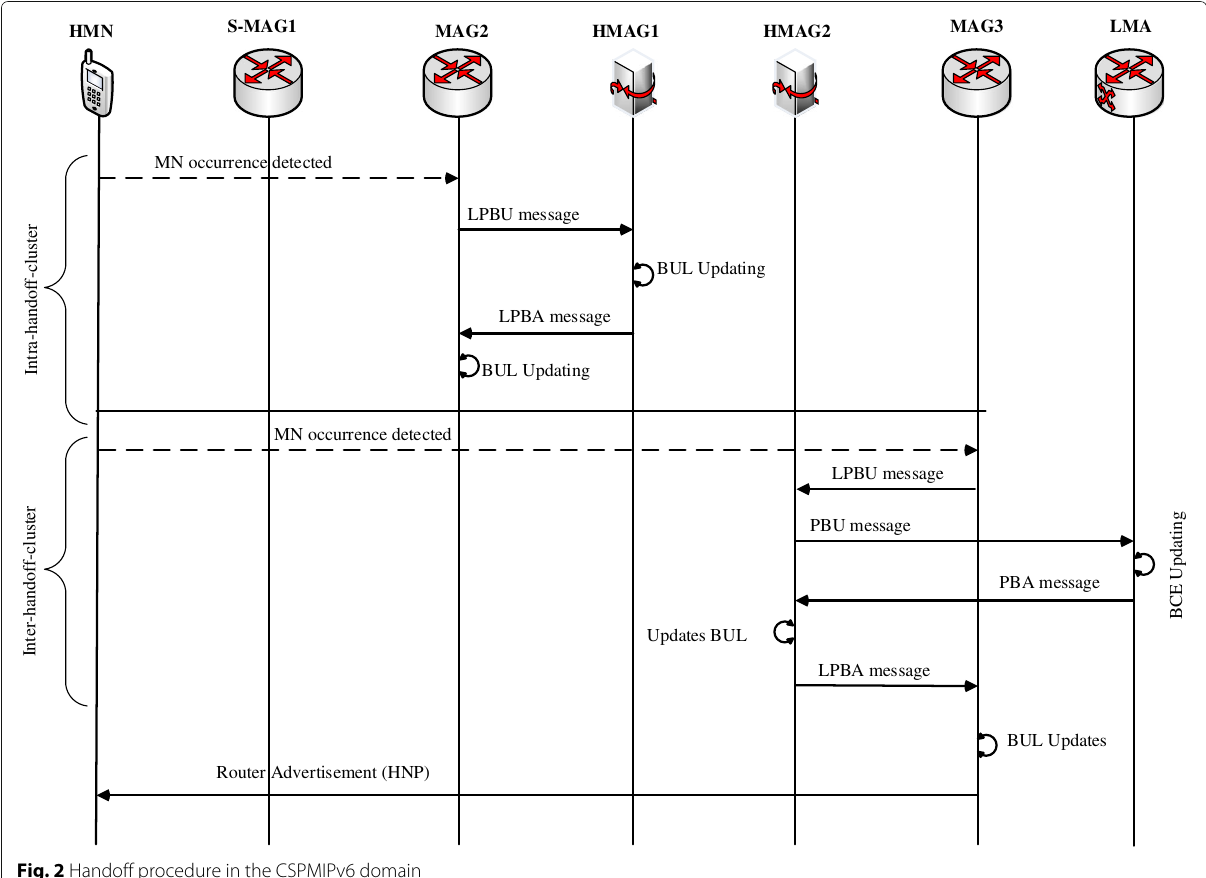
MAGs also sends a heartbeat message to the LMA, includ- ing their load status. The LMA stores the received loads in its BCE used to measure the overall system perfor- mance. The description of this is shown in Fig. 3. When the LMA load exceeds a specific threshold, a heartbeat message is sent by the LMA to the overloaded